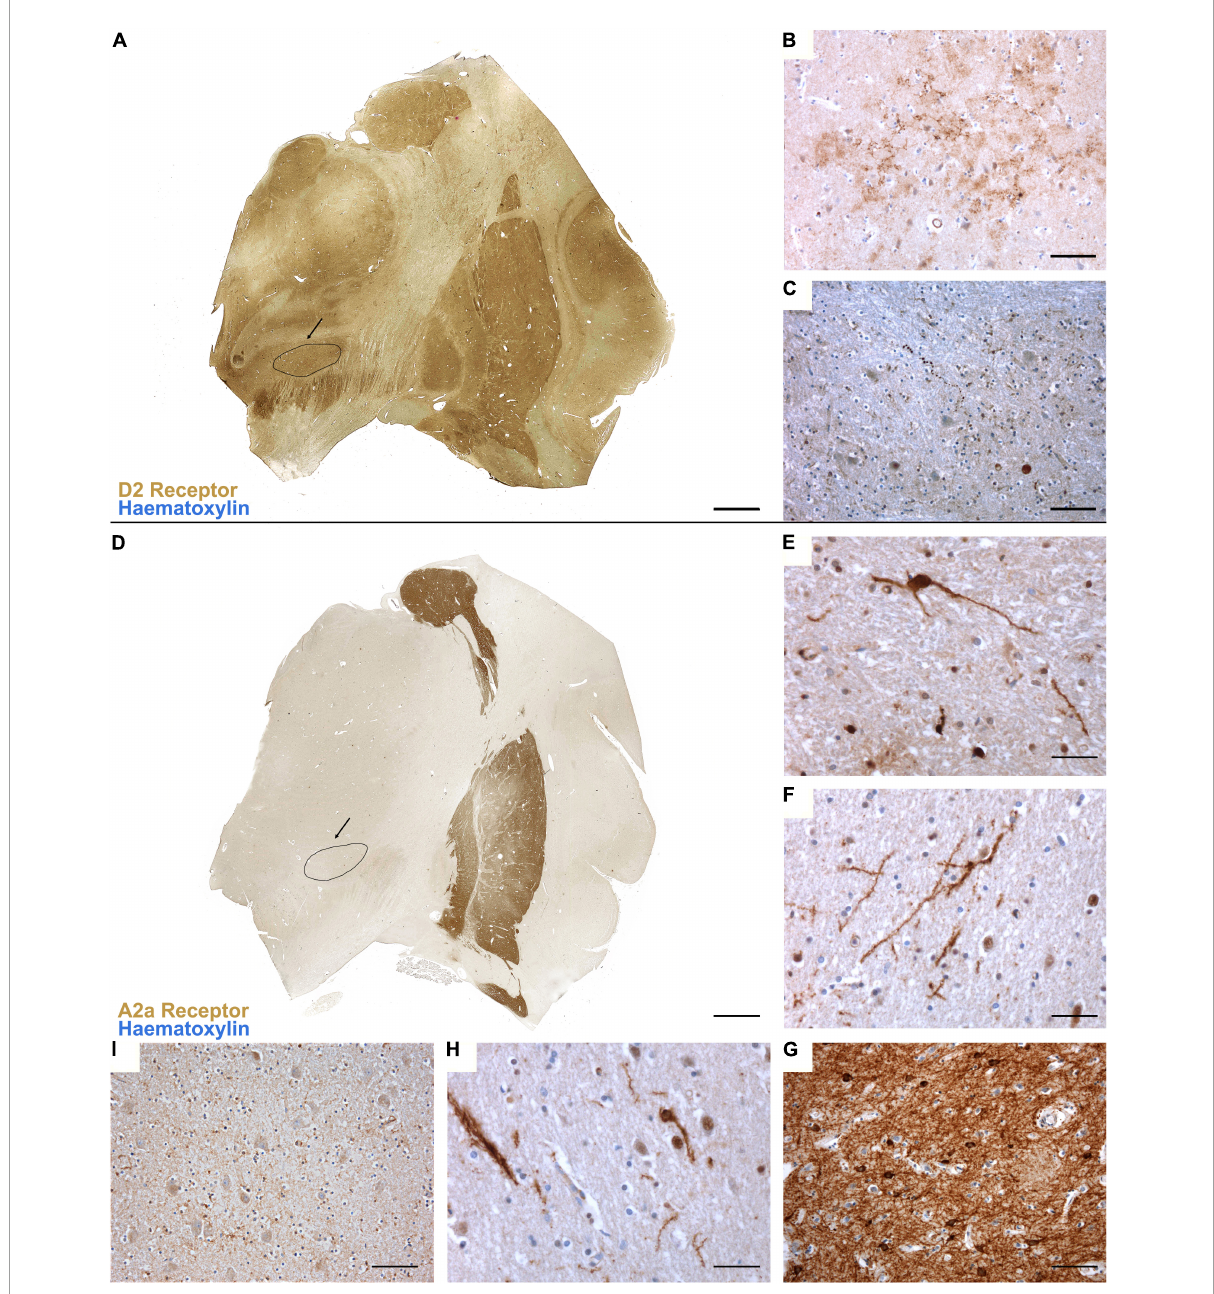
FIGURE1 (A) Topographical distribution of D 2 dopamine receptor in the basal ganglia. Immunoperoxidase staining reveals a moderate, yet diffuse, distribution of the receptor, with no marked differences between the striatum, globus pallidus and subthalamic nucleus (evidenced in black). (B) D 2 R immunoreactivity in the striatum and (C) in the subthalamic nucleus, where mainly neurites and dot-like reactivities are marked. (D) Topographical distribution of A 2 A adenosine receptor in the basal ganglia reveals a marker expression of the receptor in the striatum (G) and external globus pallidus, with very mild expression in the internal globus pallidus (E) , claustrum (F) , thalamus and subthalamic nucleus [evidenced in black, (H,I) ].